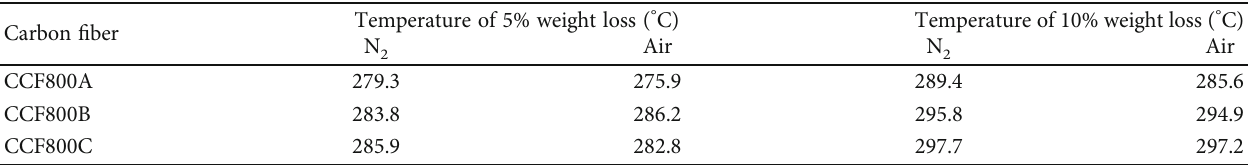
Table 5: The weight loss of sizing agents.